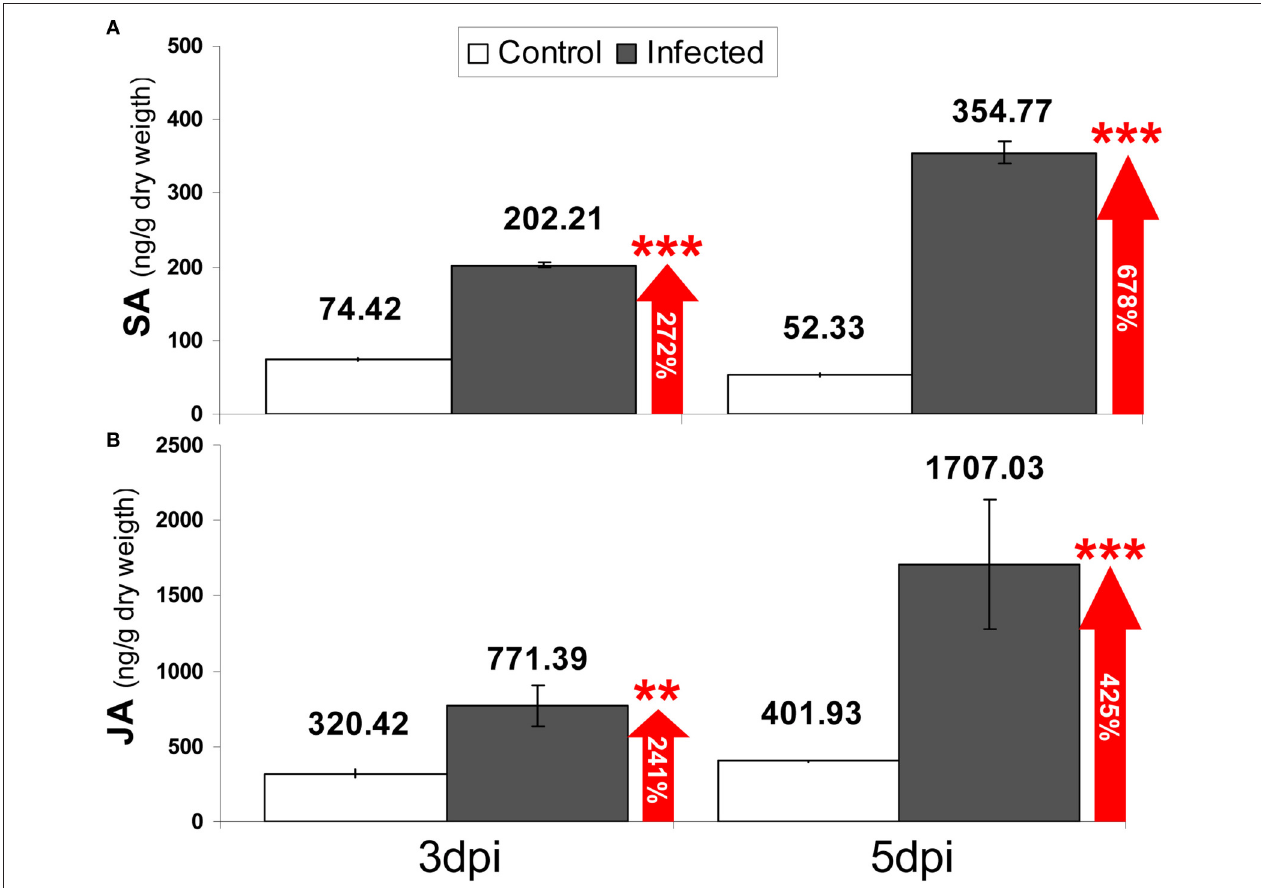
FIGURE 7 | Quantification of (A) SA and (B) JA [ng g-1 (dry weigh)] in aerial tissues of in-vitro strawberry plantlets at 3 and 5 days after mock (white bars) and pathogen inoculation (black bars). Data are the mean of three biological replicates, and error bars represent the SD. Numbers inside arrows indicate percentage of increase of infected samples vs. mock. Asterisks indicate confidence of ANOVA-Bonferroni Multiple Comparisons Test ( *** p < 0.001; ** p <